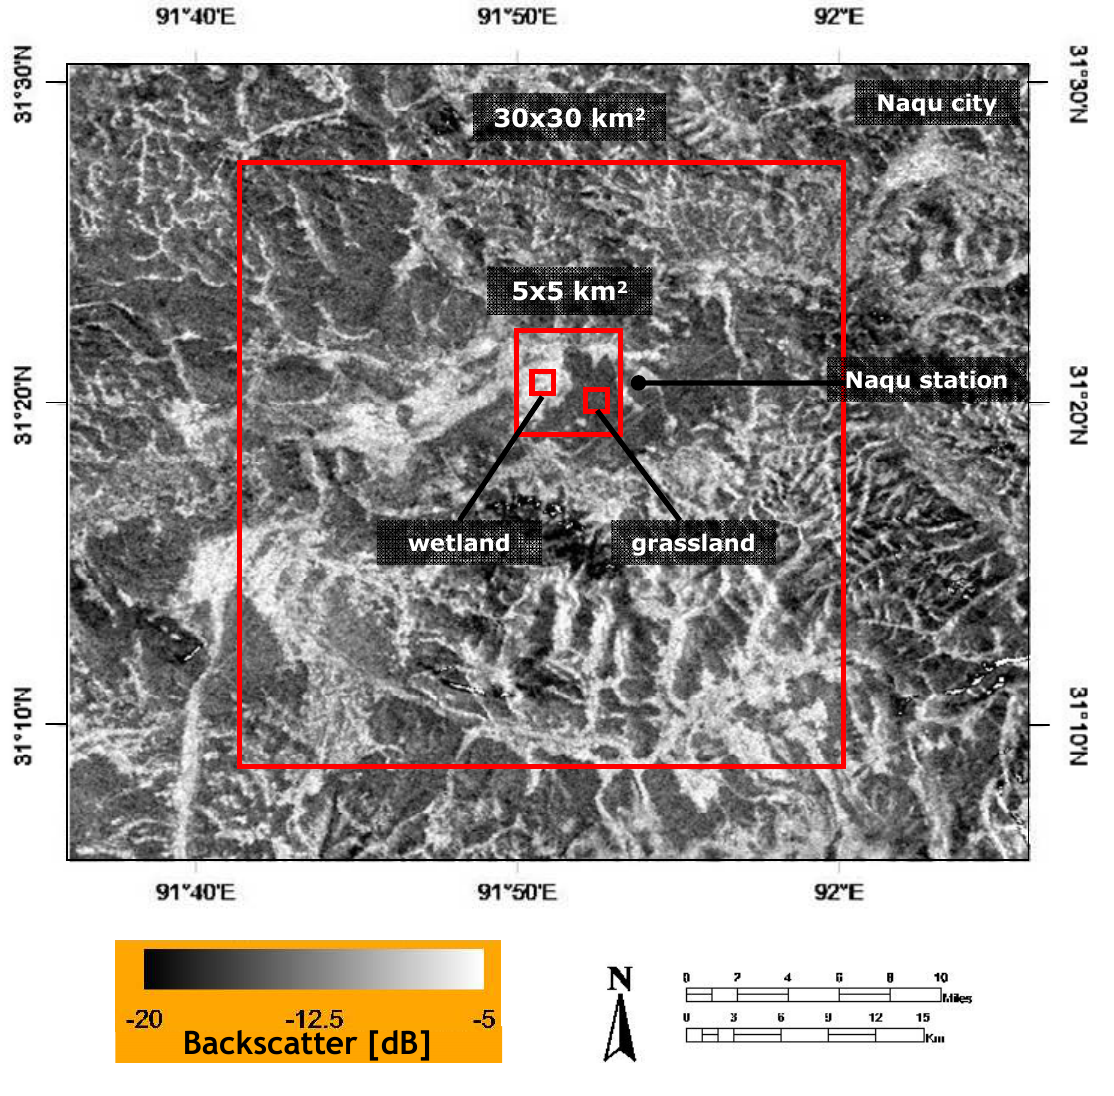
Figure 2. Positioning of the selected 30x30 km 2 , 5x5 km 2 and 1x1 km 2 wetland and grassland domains with the study area and the location of Naqu